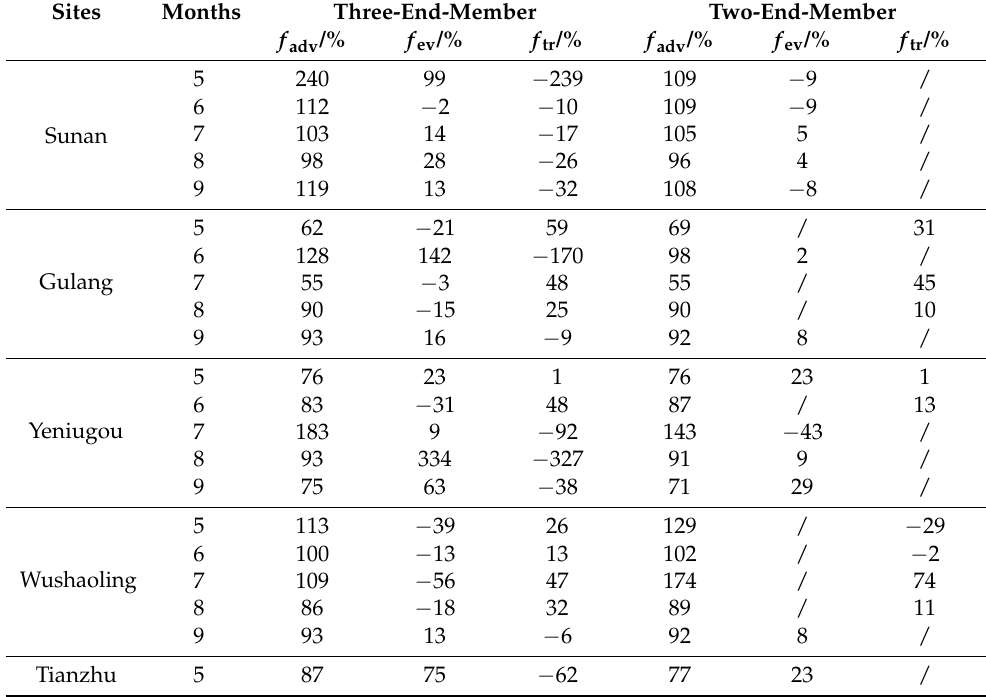
Table 5. Percent contributions of the advected vapor ( f adv ), evaporated vapor ( f ev ) and transpirated vapor ( f tr ) to precipitation using linear mixing model in the Qilian